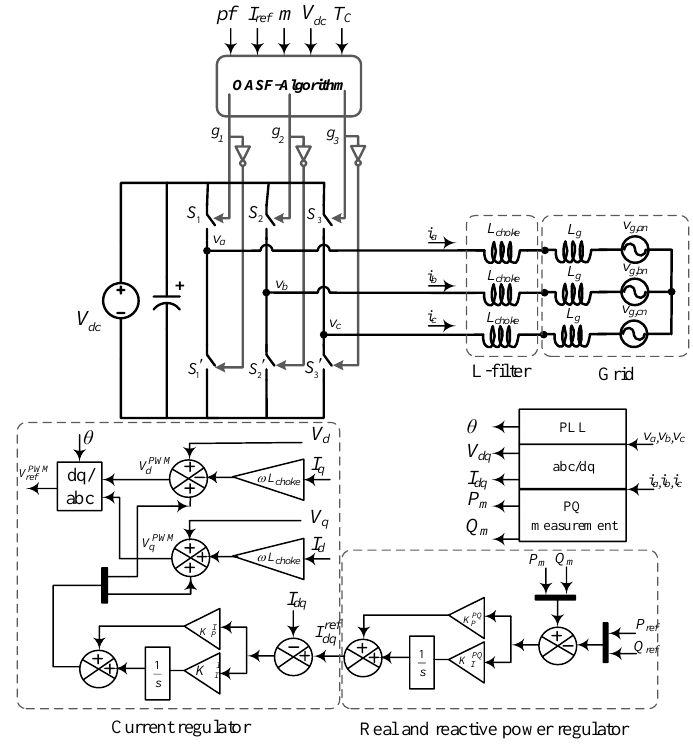
Figure 1. Schematic representation of grid-feeding VSI using the adopted OASF algorithm. If a sinusoidal current is flowing through a power-electronic module, P CQ and P CD can be formulated as in Equations (1) and (2).